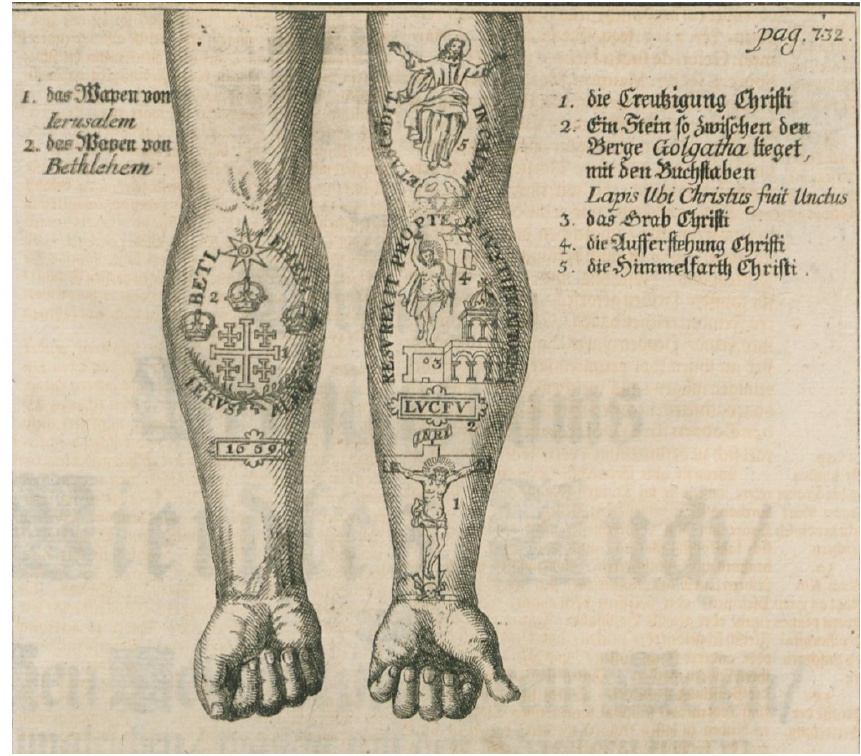
Figure 7. The Lutheran Ratger Stubbe’s pilgrim tatoos from Jerusalem. Illustration from Johann Lund, Die alten jüdischen Heiligthümer […], 1738.